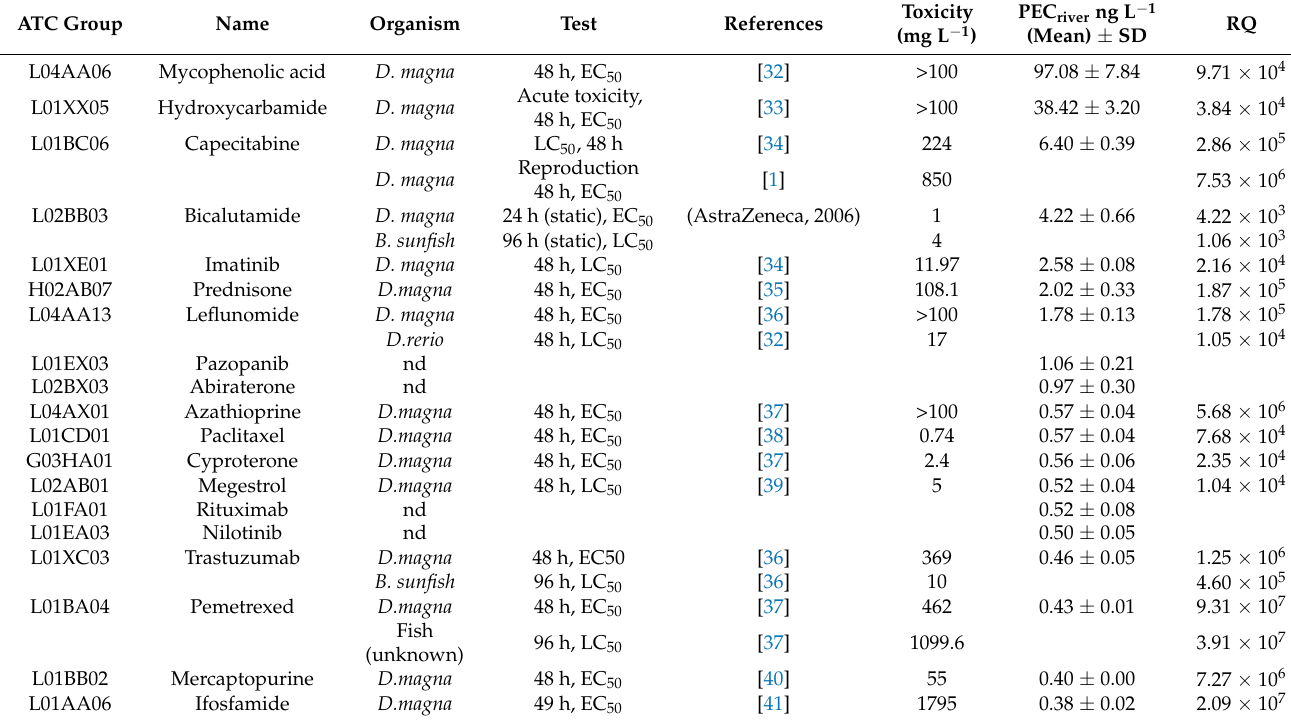
Table 4. EC 50 and LC 50 for highest PECs and riks quocient